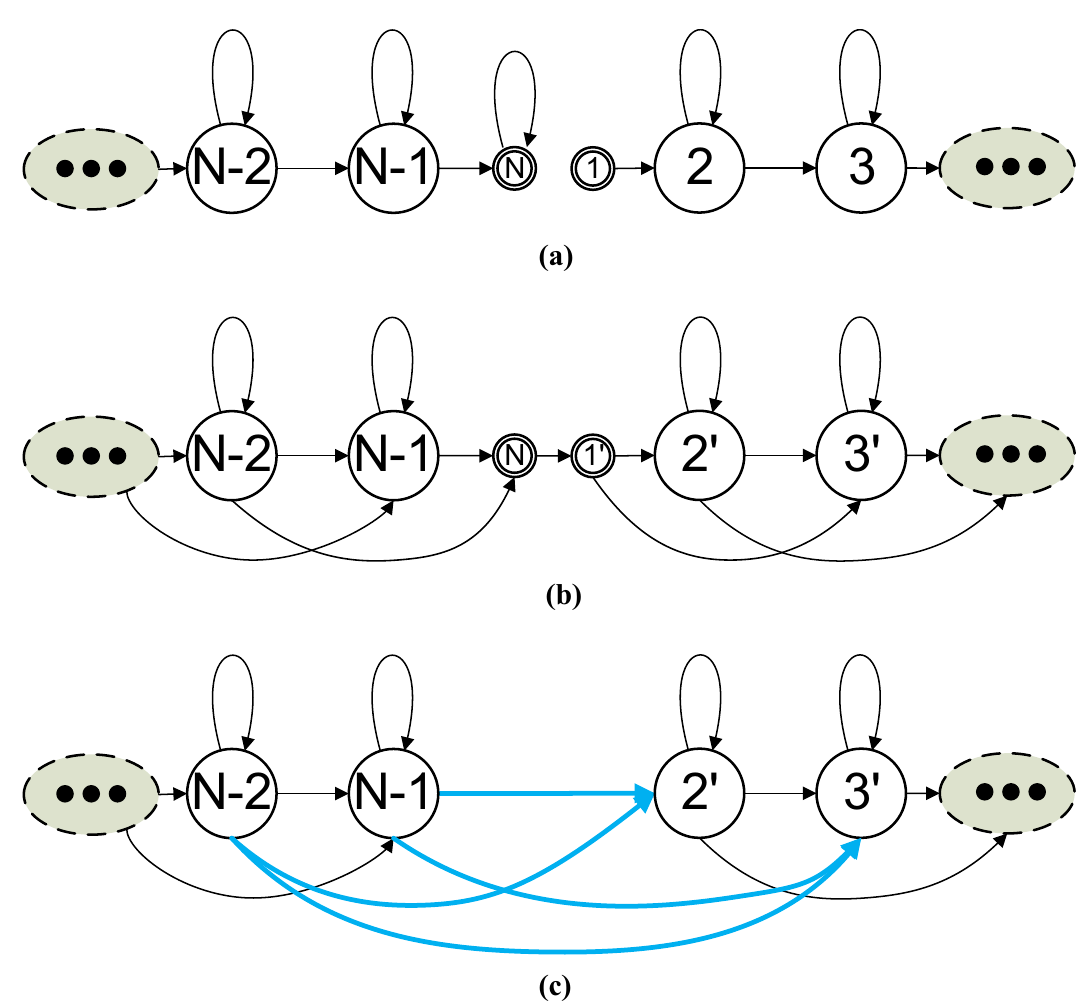
Fig 3. Illustration of the adapting-then-connecting approach for HFR adaptation of HMMs. (a) Two individual original FFR HMMs. (b) The two individually adapted HMMs are concatenated. (c) The equivalent HMM of (b) when the passing-through null states are